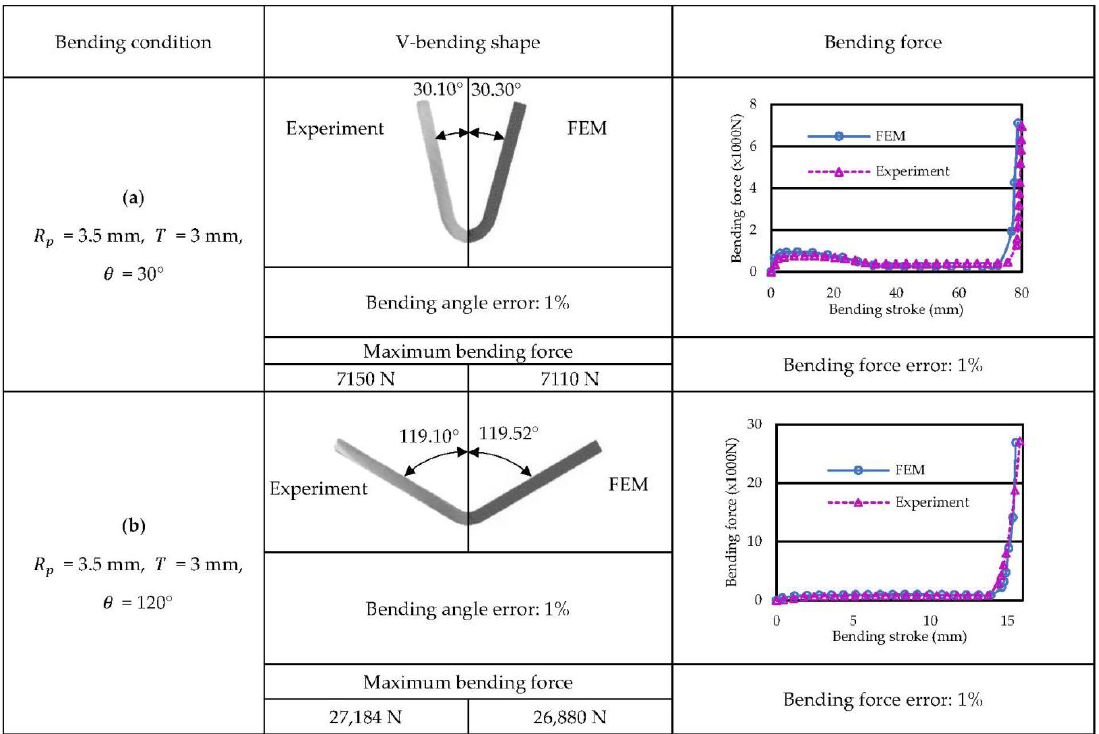
Figure 5. Comparison of V-bending shapes from FEM simulation and experimental results (AA1100-O, 𝐿 = 70 mm, l k = 60 mm).